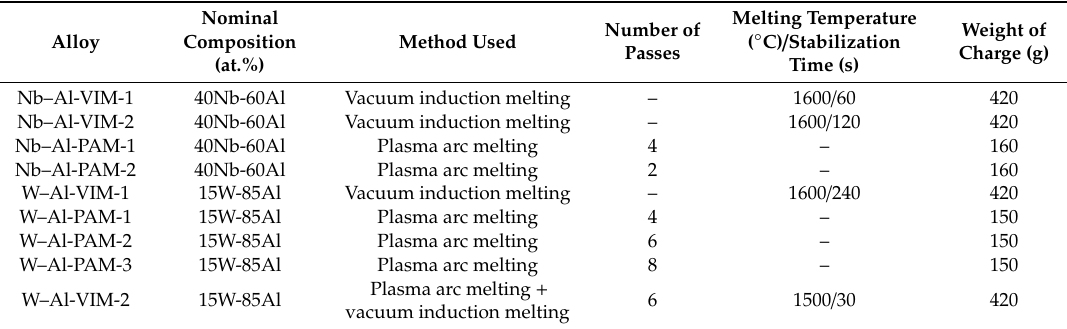
Table 1. List of all prepared